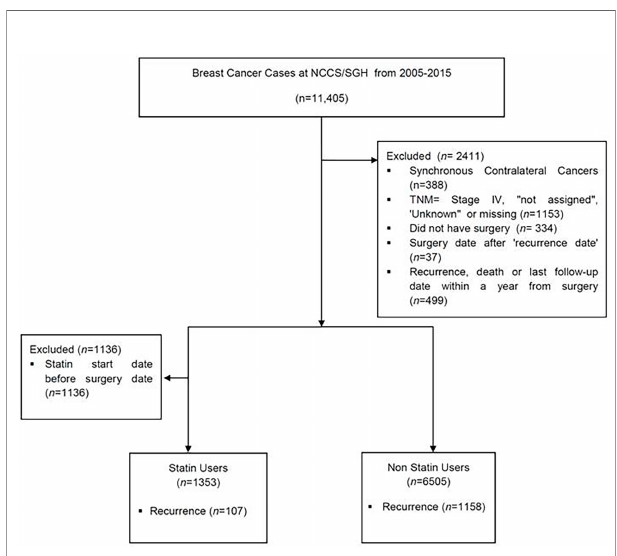
FIGURE 1 | CONSOT Diagram to summarize the number of patients included and excluded in this study. NCCS, National Cancer Centre Singapore; SGH, Singapore General Hospital; TNM, Tumor Nodal Metastasis